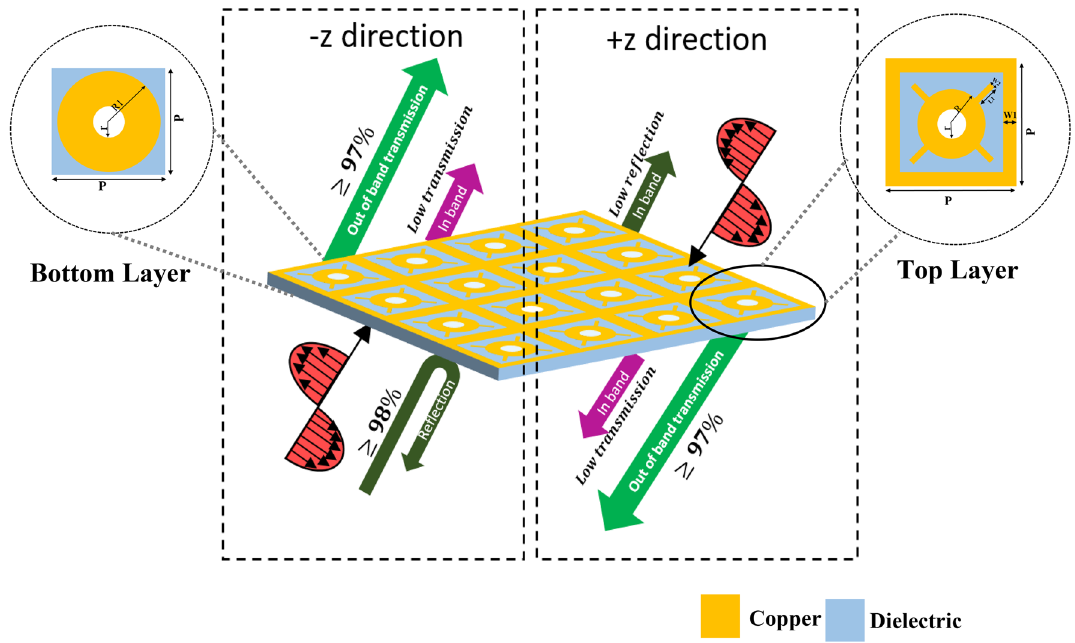
Figure 1. Schematic diagram of the omega bianisotropic metasurface along with geometric configuration of the top and bottom metallic layers of the unit cell. *The figure is created using Microsoft Power Point-Office 365- URL: https:// www. office. com/ power